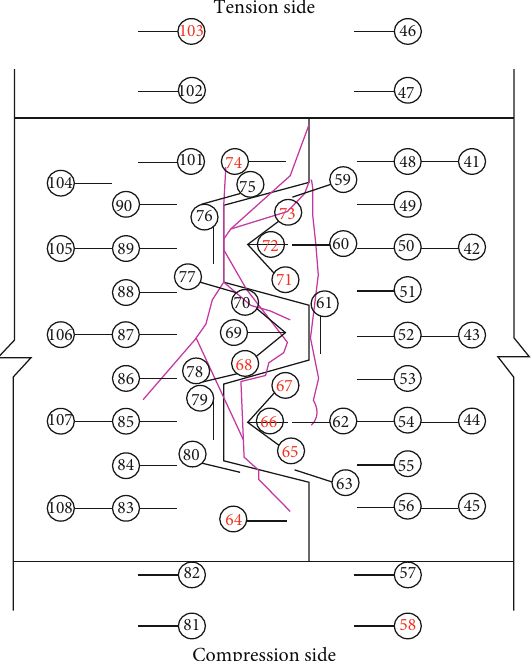
Figure 10: Strain gauge arrangement of concrete surface for an axial load of